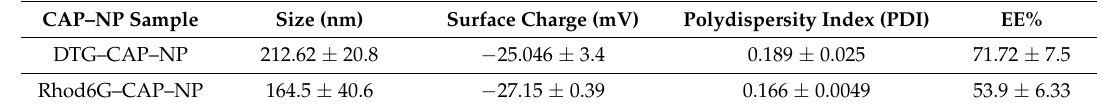
Table 1. Physiochemical Characterization of CAP Nanoparticles.